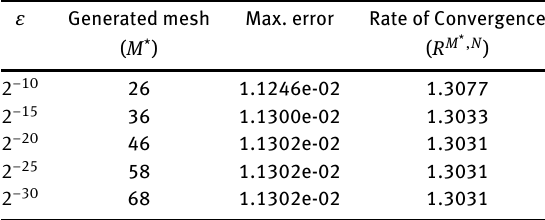
Table 3: Maximum point wise errors of the solution and correspond- ing rate of convergence for Example 5.2 by taking δ = 0 , η = 0.5 , M=10 and N=20 for different values of ε .